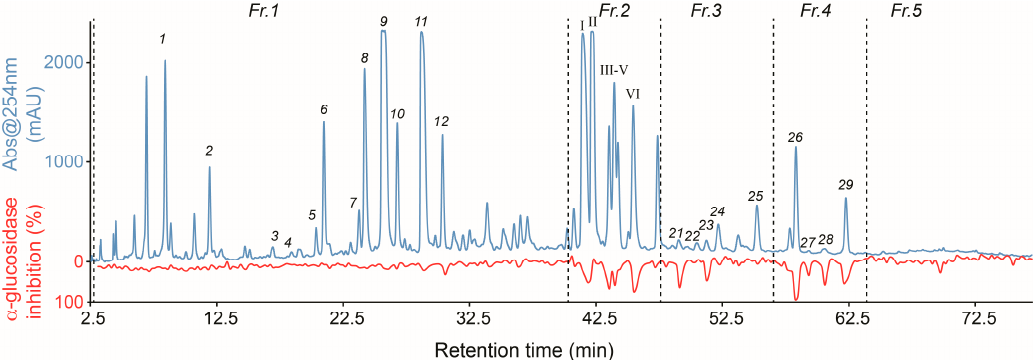
Figure 1. High-resolution α -glucosidase inhibition profile (red line) of defatted ethyl acetate extract of E. crotonoides shown underneath the HPLC chromatogram (blue line) at 254 nm. Fr.1–Fr.5 indicates the five regions collected by preparative-scale HPLC on C 18 column for subsequent HPLC-HRMS-SPE-NMR analysis using analytical-scale pentafluorophenyl column